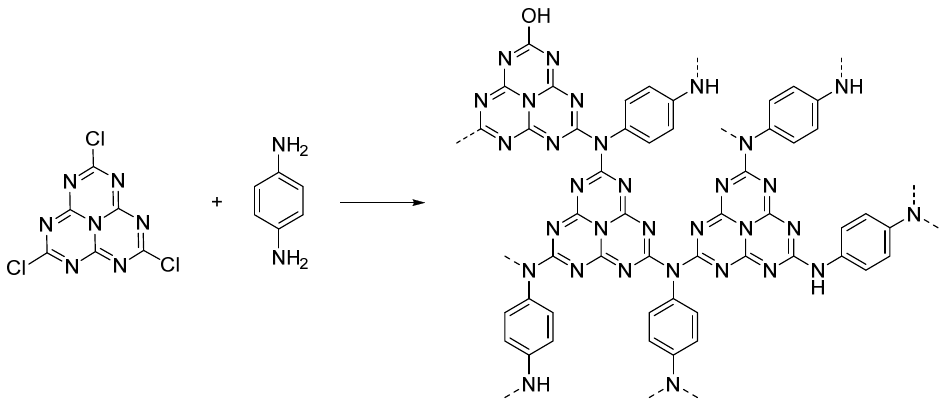
Figure 26. Heptazine-based microporous network obtained through low temperature condensa- tion [123].